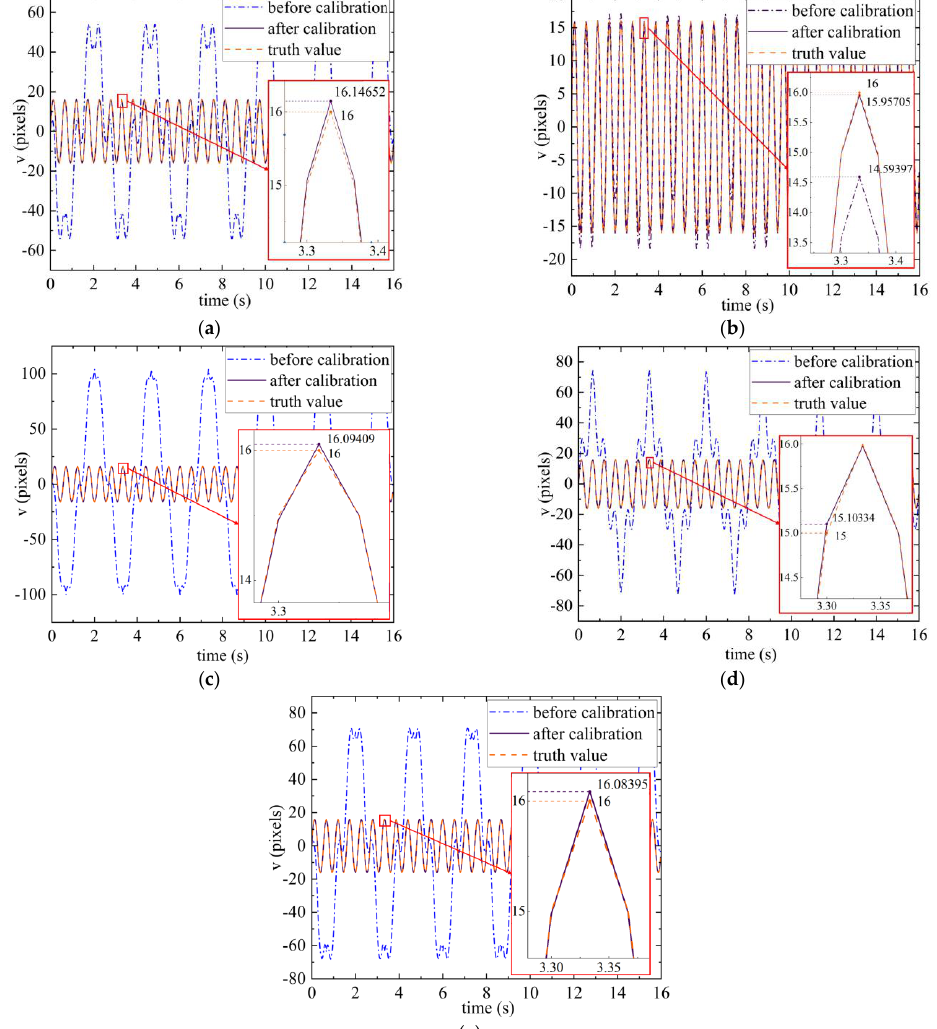
Figure 9. Displacement time–history of the upper left corner point before nd after camera calibration in all cases: ( a ) case 1; ( b ) case 2; ( c ) case 3; ( d ) case 4; ( e ) case 5.